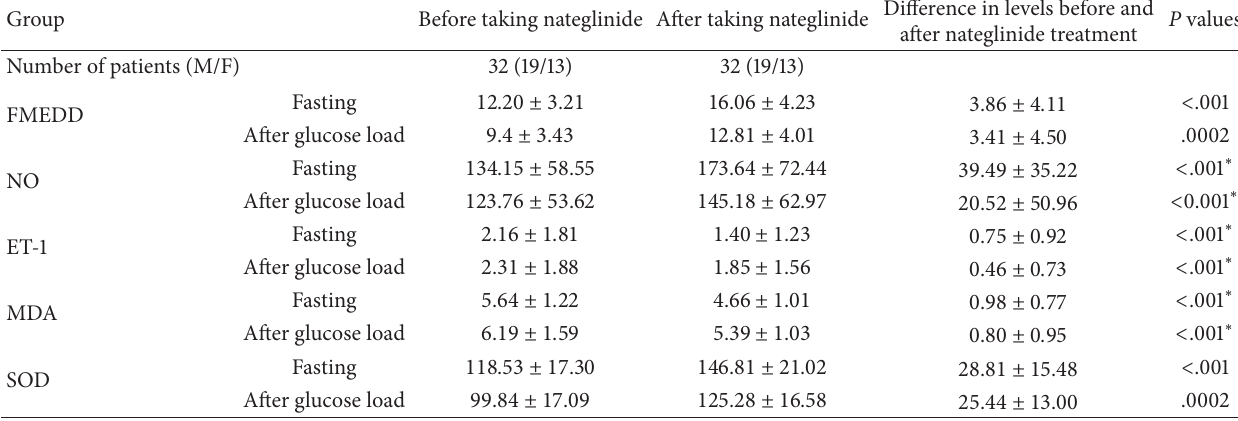
Difference in levels before and P values after nateglinide treatment